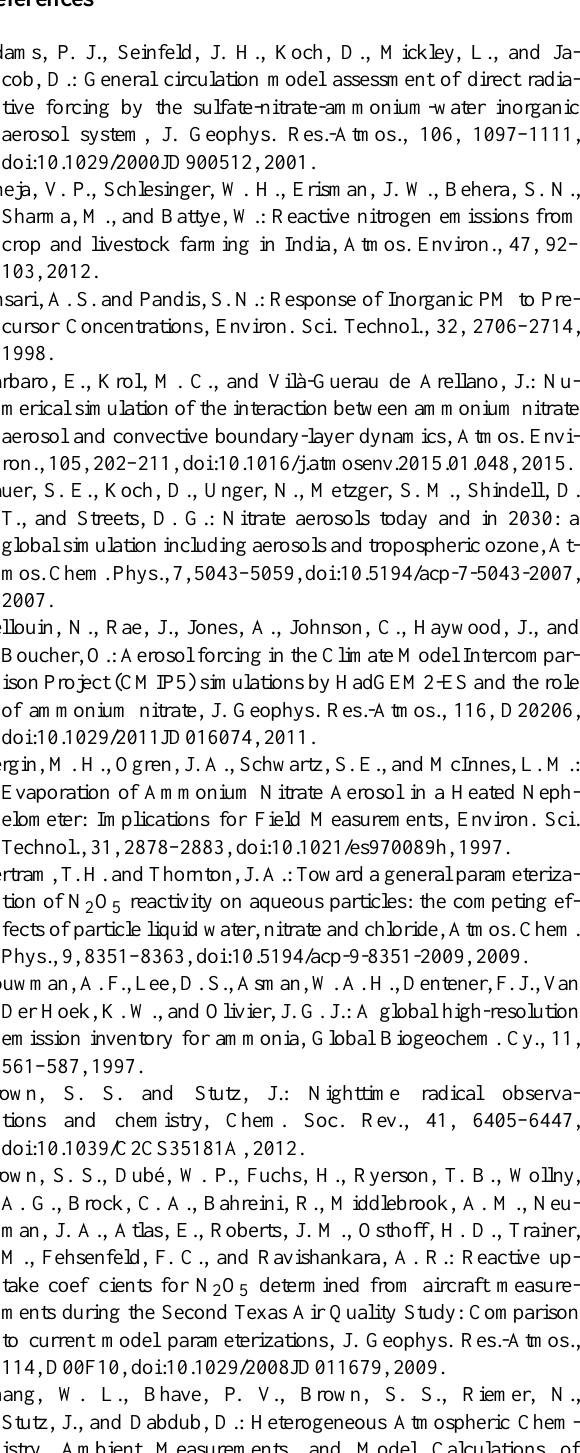
in AM3N 3 burden located 3 simu- 3 3